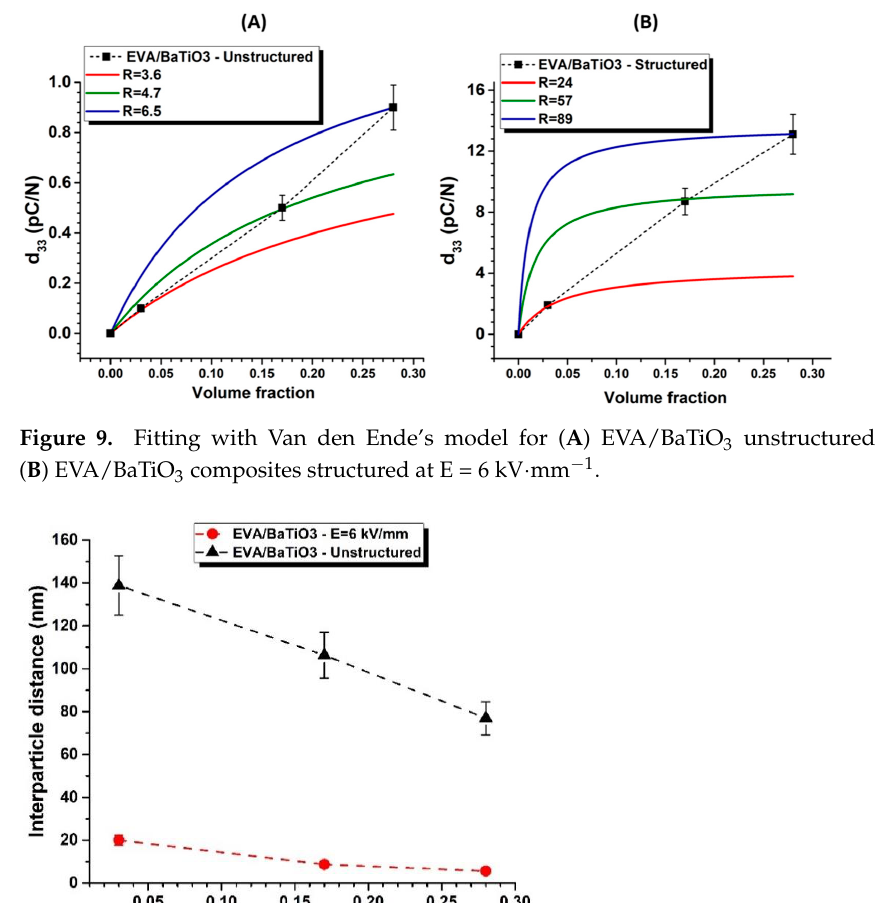
Figure 10. Inter-particle distance in the thickness direction as function of the volume fraction of BaTiO 3 for structured and unstructured composites, following Van den Ende’s model.